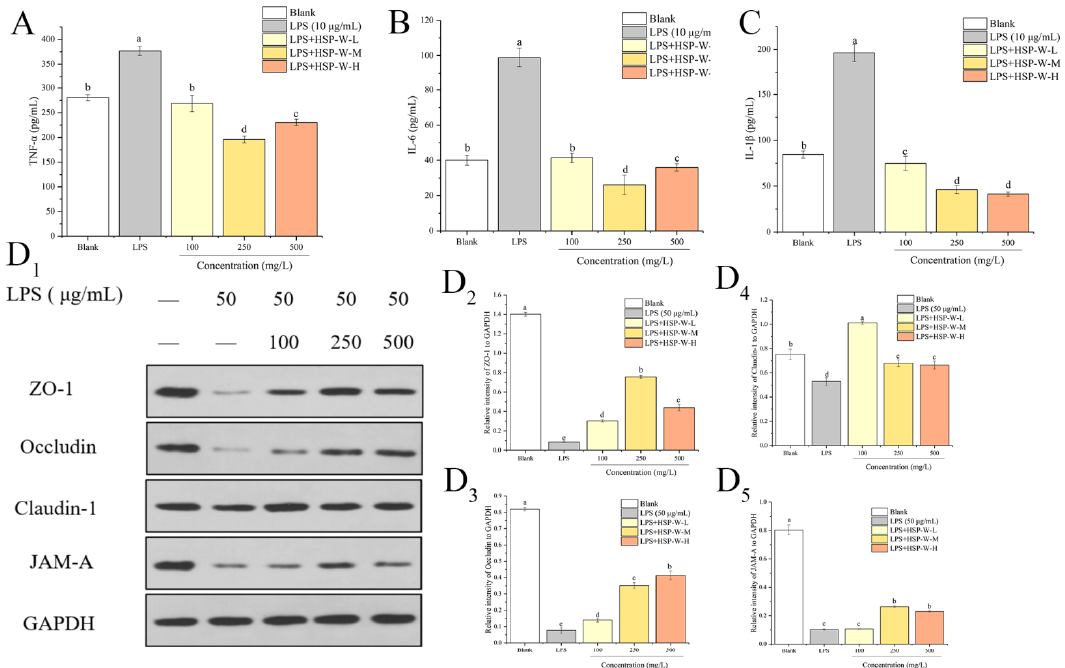
Figure 3. Effects of HSP-W on proinflammatory cytokines and TJ protein expressions in Caco-2 cells: ( A ) TNF- α , ( B ) IL-6, ( C ) IL-1 β , and ( D ) TJ proteins. Data were shown as the mean ± SD from four independent experiments. Different letters represented the significant difference at p < 0.05.